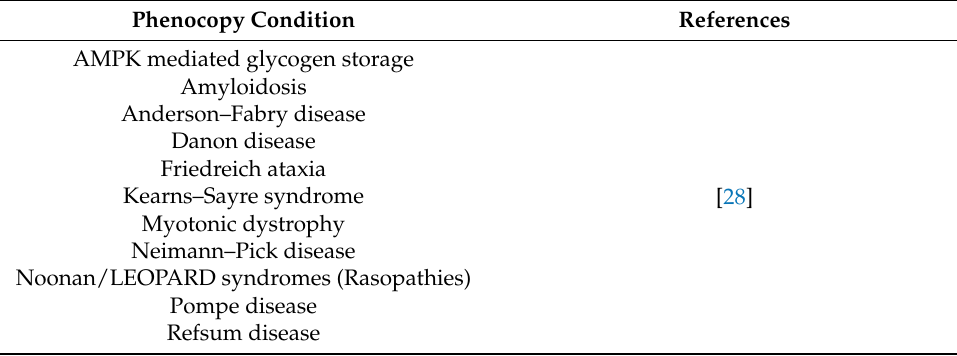
Table 1. Phenocopy conditions mimicking HCM (Marian et al.